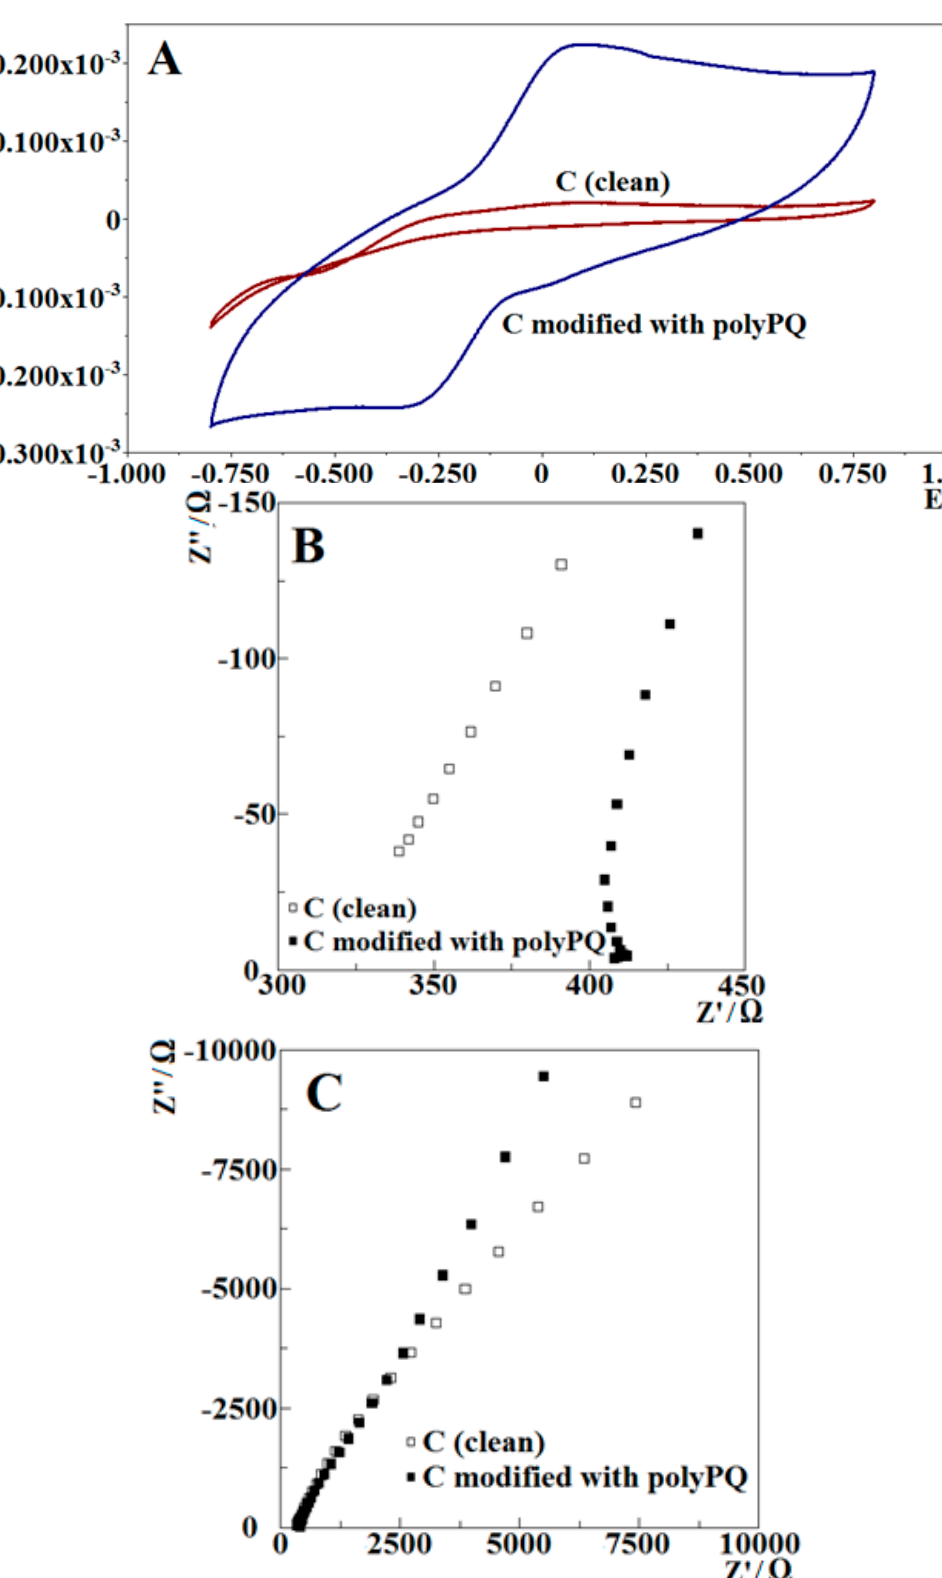
Figure 6. ( A ) Cyclic voltammograms of poly-PQ modified and unmodified GR electrodes at a scan rate of 100 mV / s in pH 6.0 A-PBS; ( B ) EIS spectra of poly-PQ modified and unmodified GR electrodes in high frequencies (40.0 kHz–16.0 Hz) and ( C ) in lower frequencies (16.0 Hz–5.00 mHz) at 0 V vs. Ag / AgCl / KCl (3M KCl) .